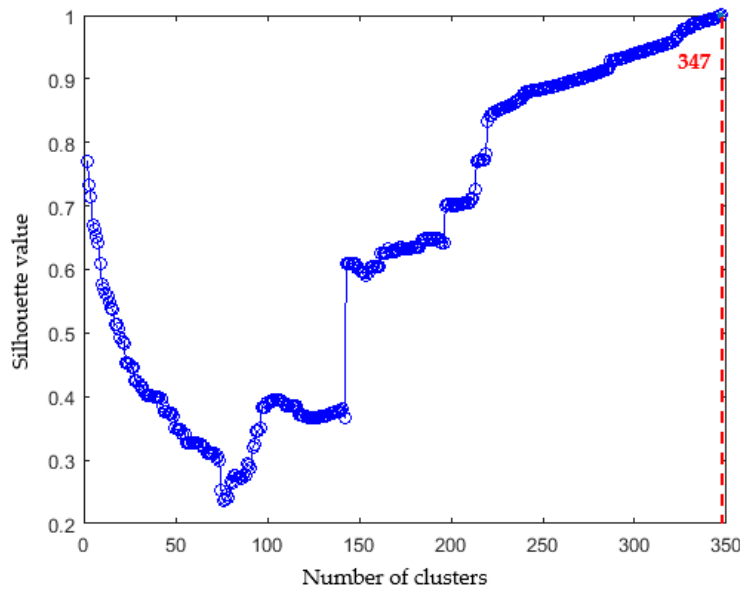
Figure 9. Silhouette value corresponding to the number of clusters.